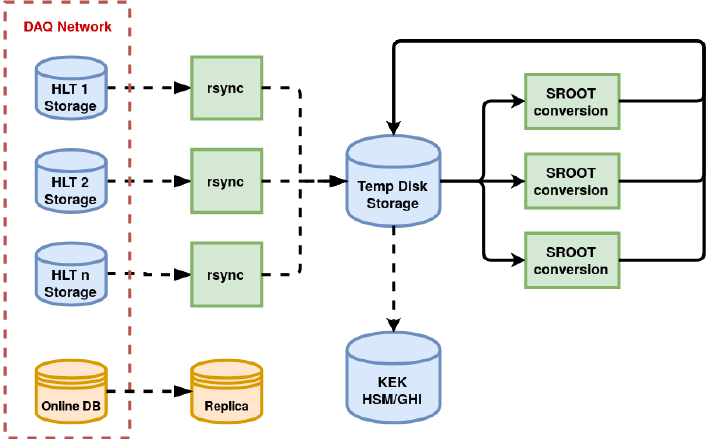
Figure 4. Flow of raw data files after a run is closed by the DAQ. SROOT files must first be copied out of the DAQ network. Then they are converted to ROOT format and stored at KEKCC, ready for upload to remote data centre storage and prompt